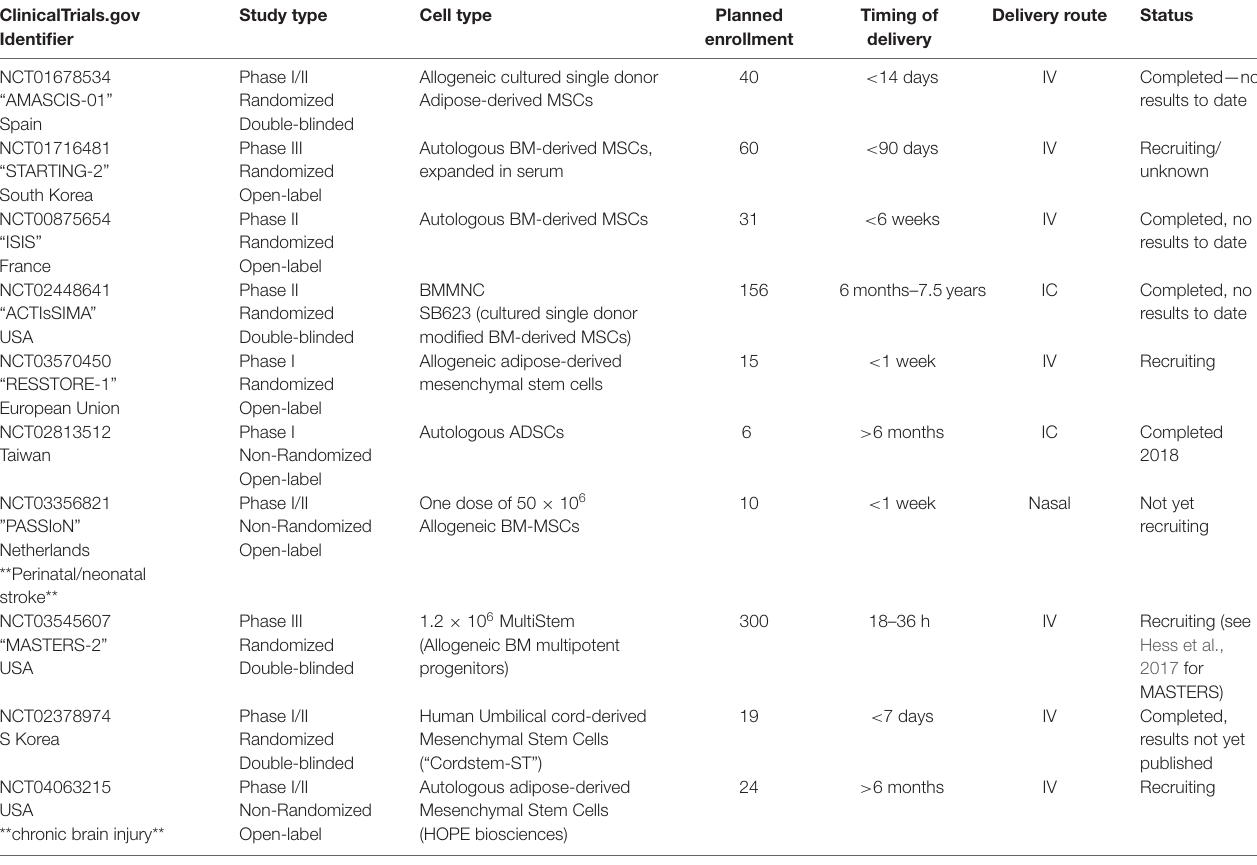
TABLE 4 | Ongoing and pending unpublished mesenchymal lineage trials.